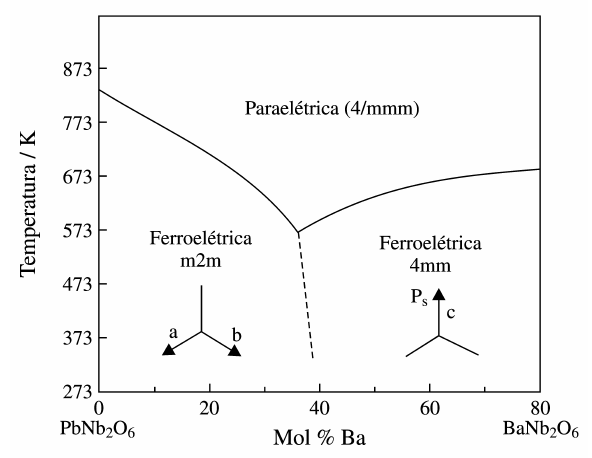
Figura 2. Diagrama de fases do sistema pseudo-binário PbNb 2 O 6 - BaNb 2 O 6